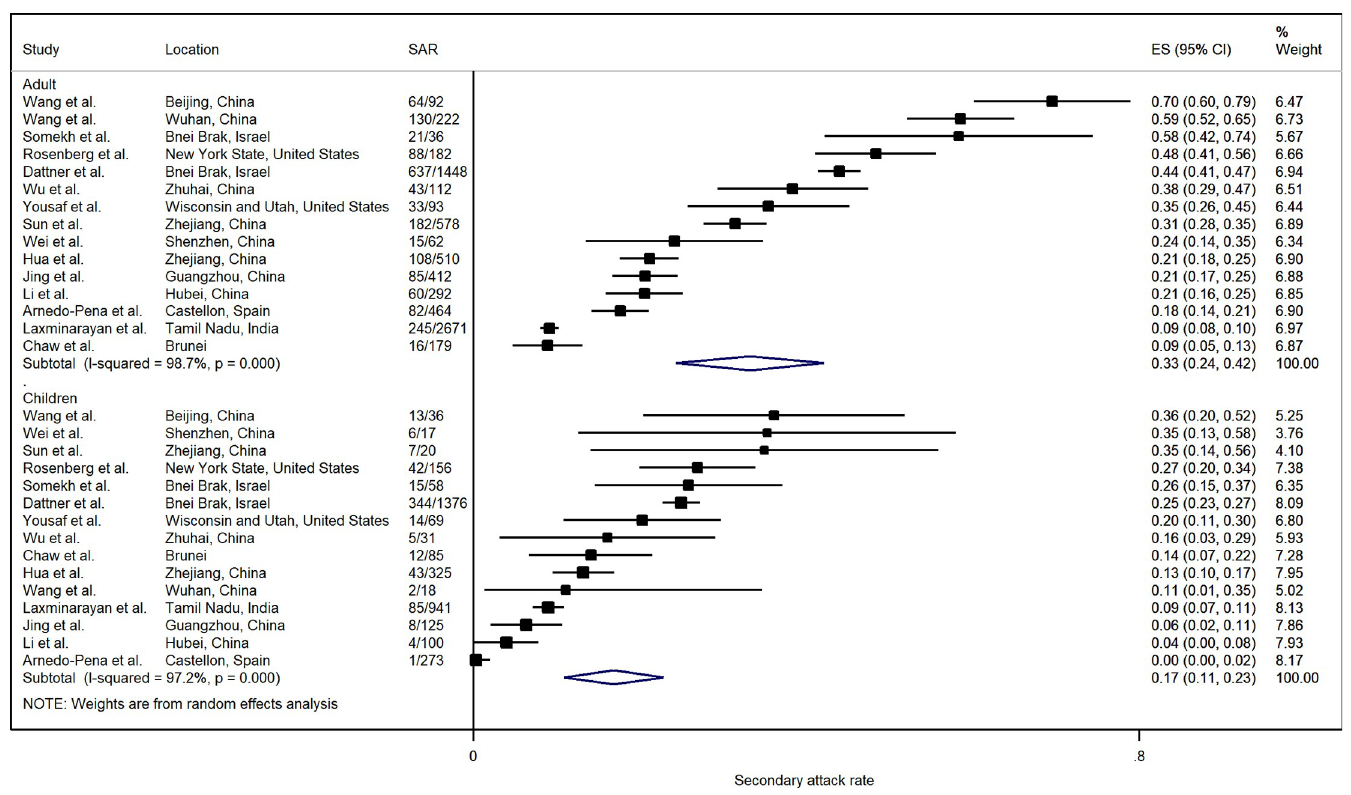
Fig 6. Forest plot of household secondary attack rates (SAR) by adult and children close contact. ES is the estimated SAR, with 95% confidence intervals (CI). I- squared is the percentage of between-study heterogeneity that is attributable to variability in the true effect, rather than sampling variation.